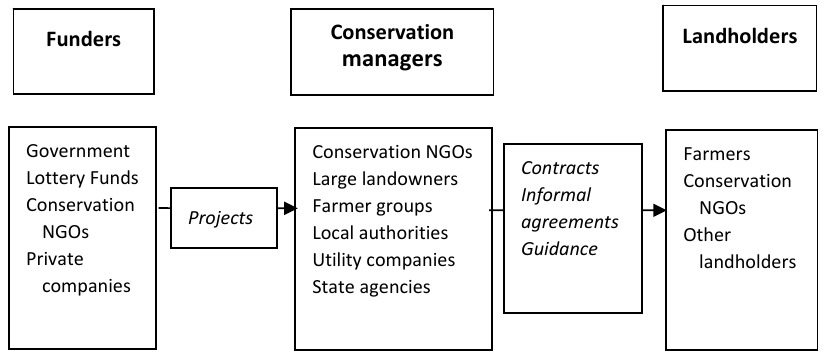
Figure 1. Funding processes for ecological restoration.